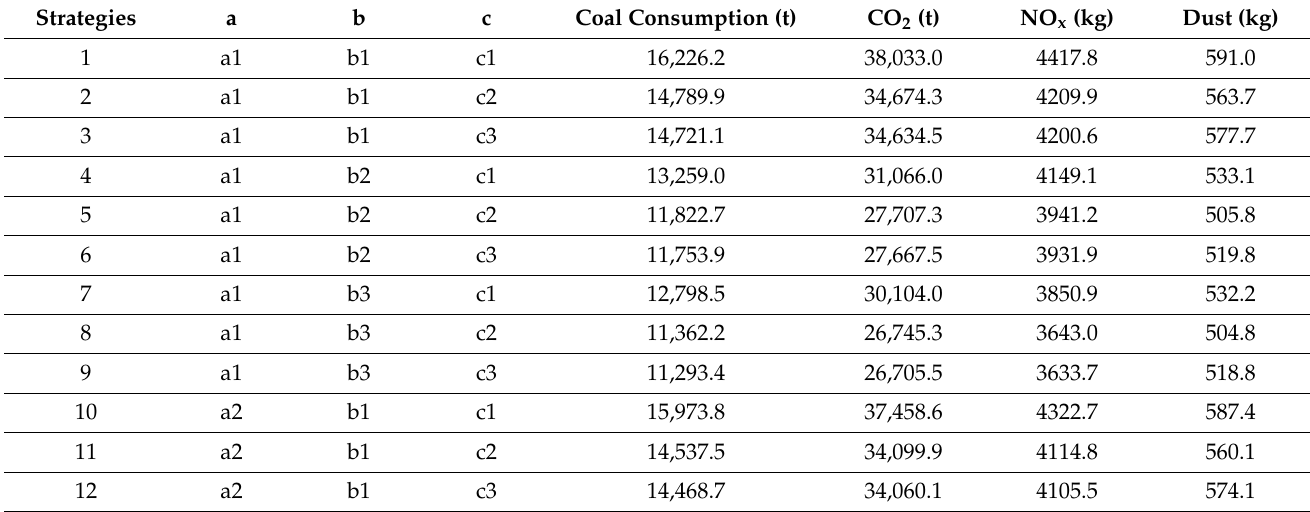
Table 8. Weekly coal consumption and atmospheric emissions from the combined decision.